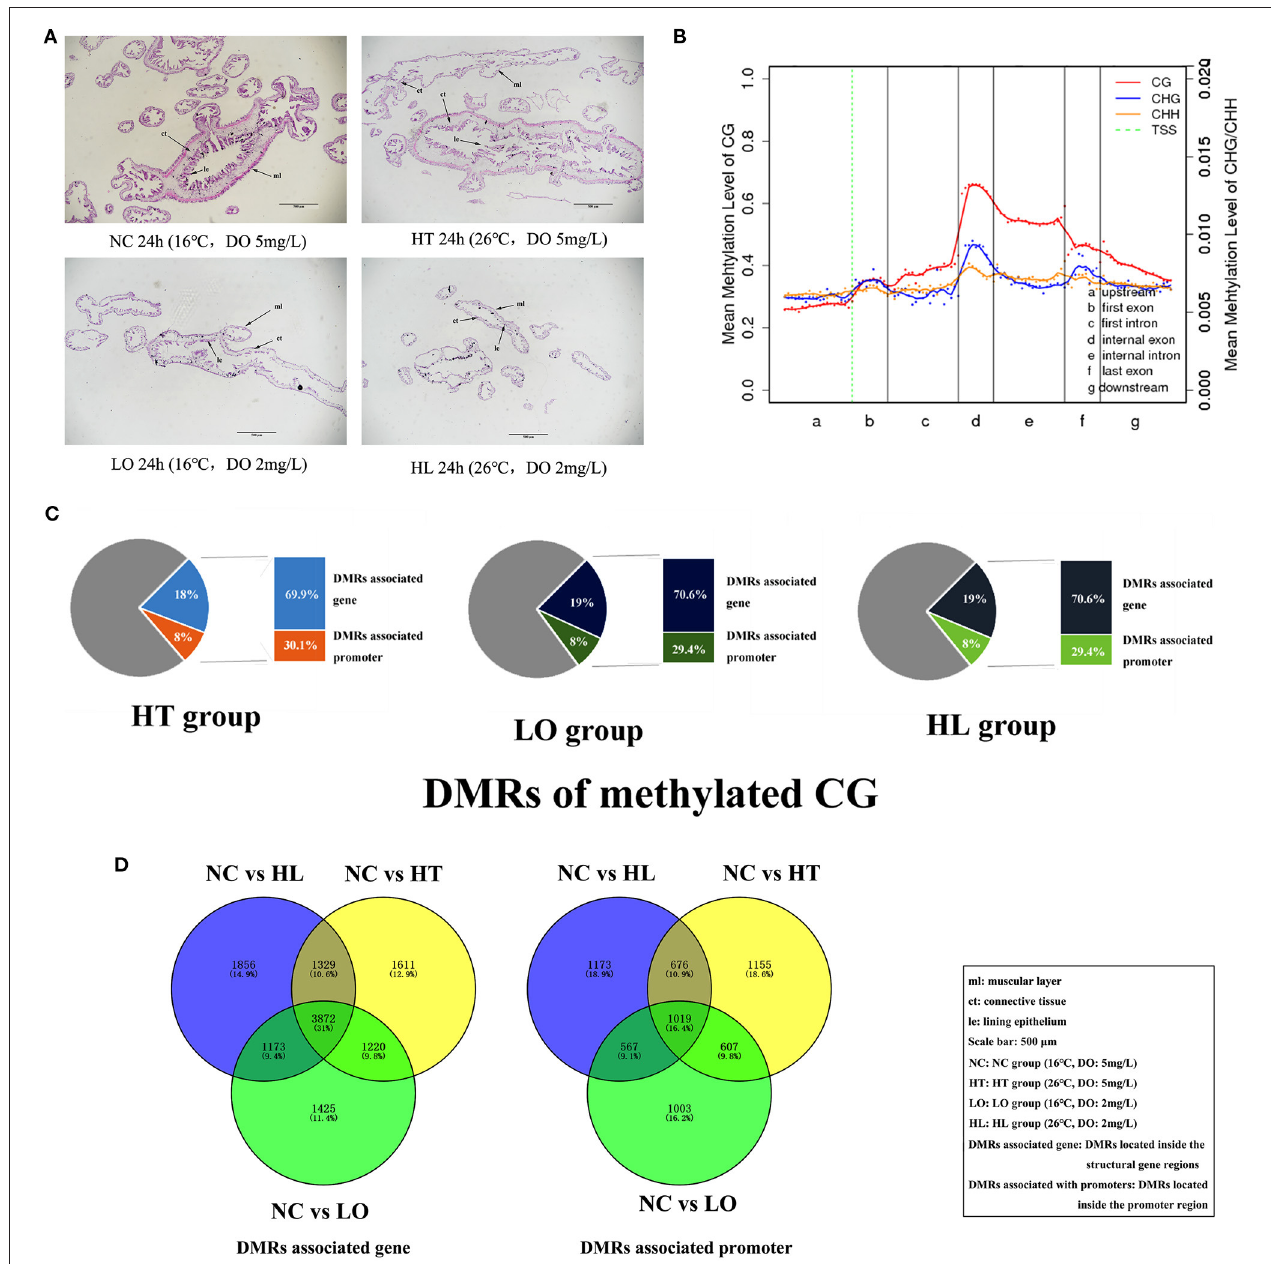
FIGURE 1 | (A) Tissue section of the respiratory tree in A. japonicus under heat stress (26 ◦ C, 5 mg/L DO), hypoxia stress (16 ◦ C, 2 mg/L DO), heat–hypoxia stress (26 ◦ C, 2 mg/L DO), and NC group (16 ◦ C, 5 mg/L DO) for 24h. ct, connective tissue; le: lining epithelium; ml, muscular layer. Scale bar 500 µ m. (B) Canonical DNA methylation profiles of the entire transcriptional units of the NC group. (C) Pie chart proportion of DMR corresponding genes, promoters, and other regions. (D) Venn diagram of the DMRs in the NC, HT, LO, and HL